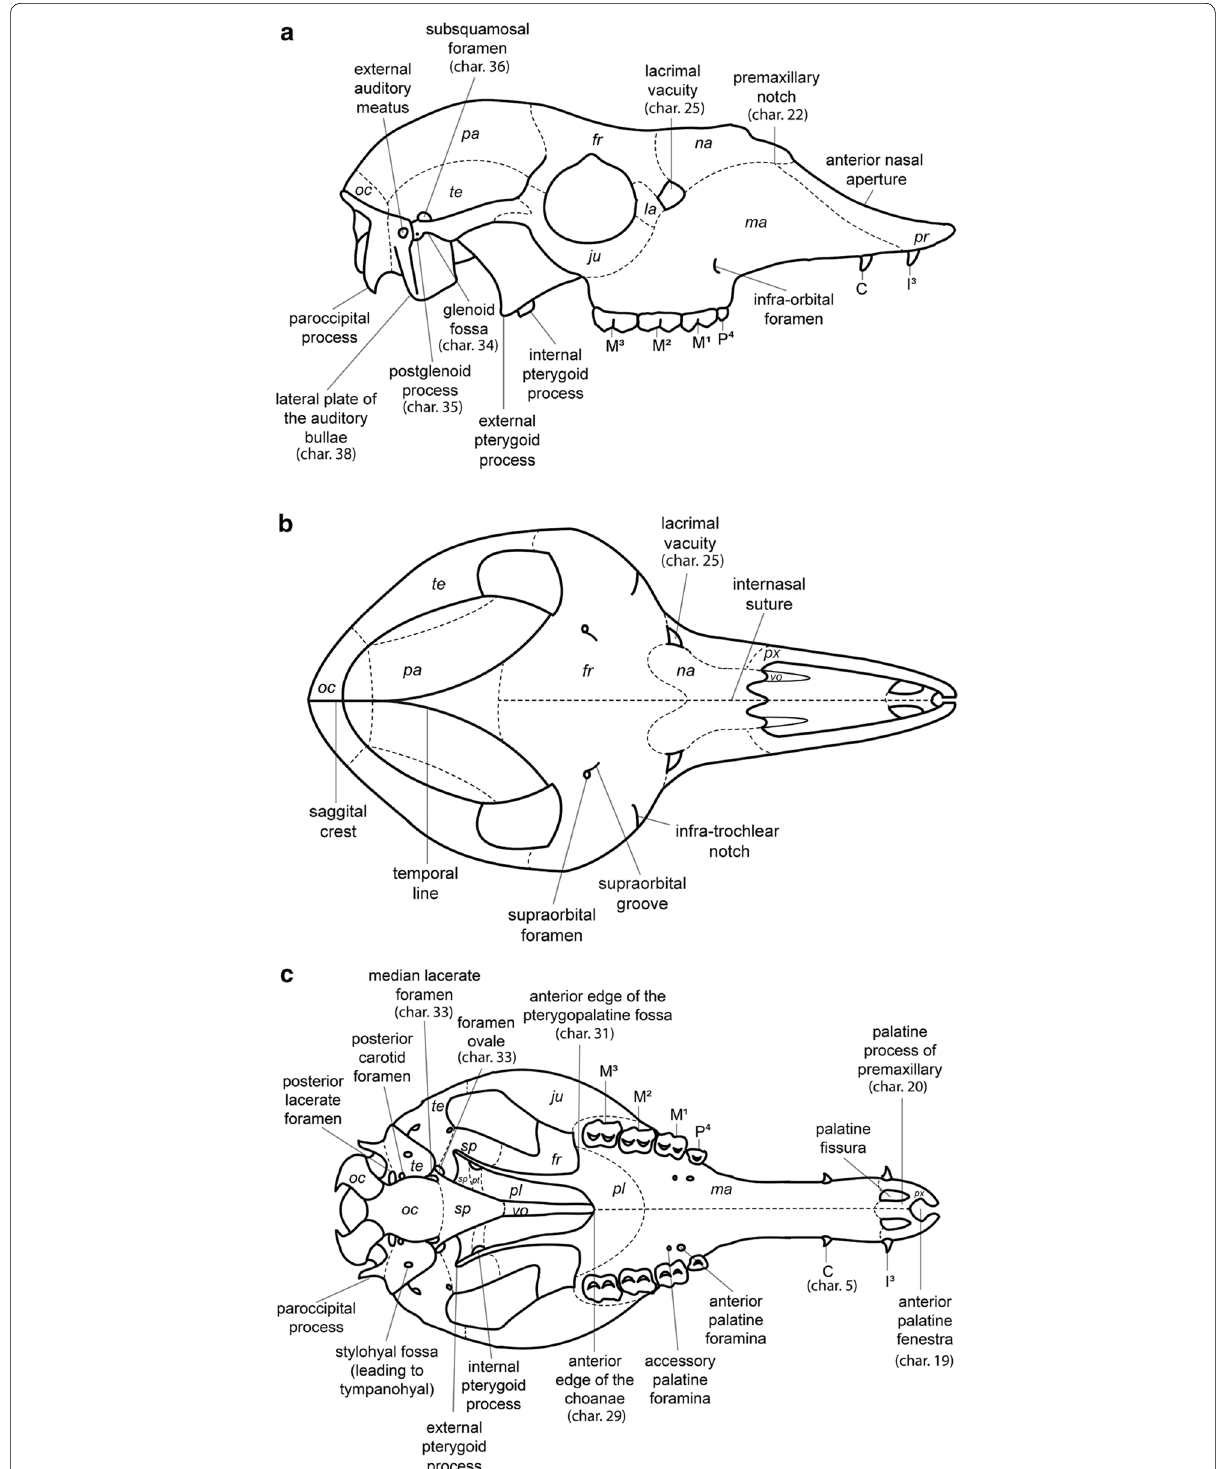
Fig. 2 Schematic drawings of L. guanicoe . a Skull, lateral view. b Skull, dorsal view. c Skull, occlusal view. d Mandible, lateral view. Abbreviations: pr premaxillary bone; ma maxillary bone; fr frontal bone; la lacrimal bone; ju jugal bone; te temporal bone; oc occipital bone; = = = = = = = sp sphenoid bone; pt pterygoid bone; vo vomer bone; pl palatine bone; pa parietal bone; I 3 third upper incisor; I 1 first lower = = = = = = = incisor; I 2 second lower incisor; I 3 third lower incisor; C Upper canine; c Lower canine; P 1 first upper premolar; P 1 first lower premolar; = = = = = = P 2 second lower premolar; P 4 fourth upper premolar; P 4 fourth lower premolar; M 1 first upper molar; M 1 first lower molar; M 2 second = = = = = = upper molar; M 2 second lower molar; M 3 third upper molar; M 3 third lower = = =